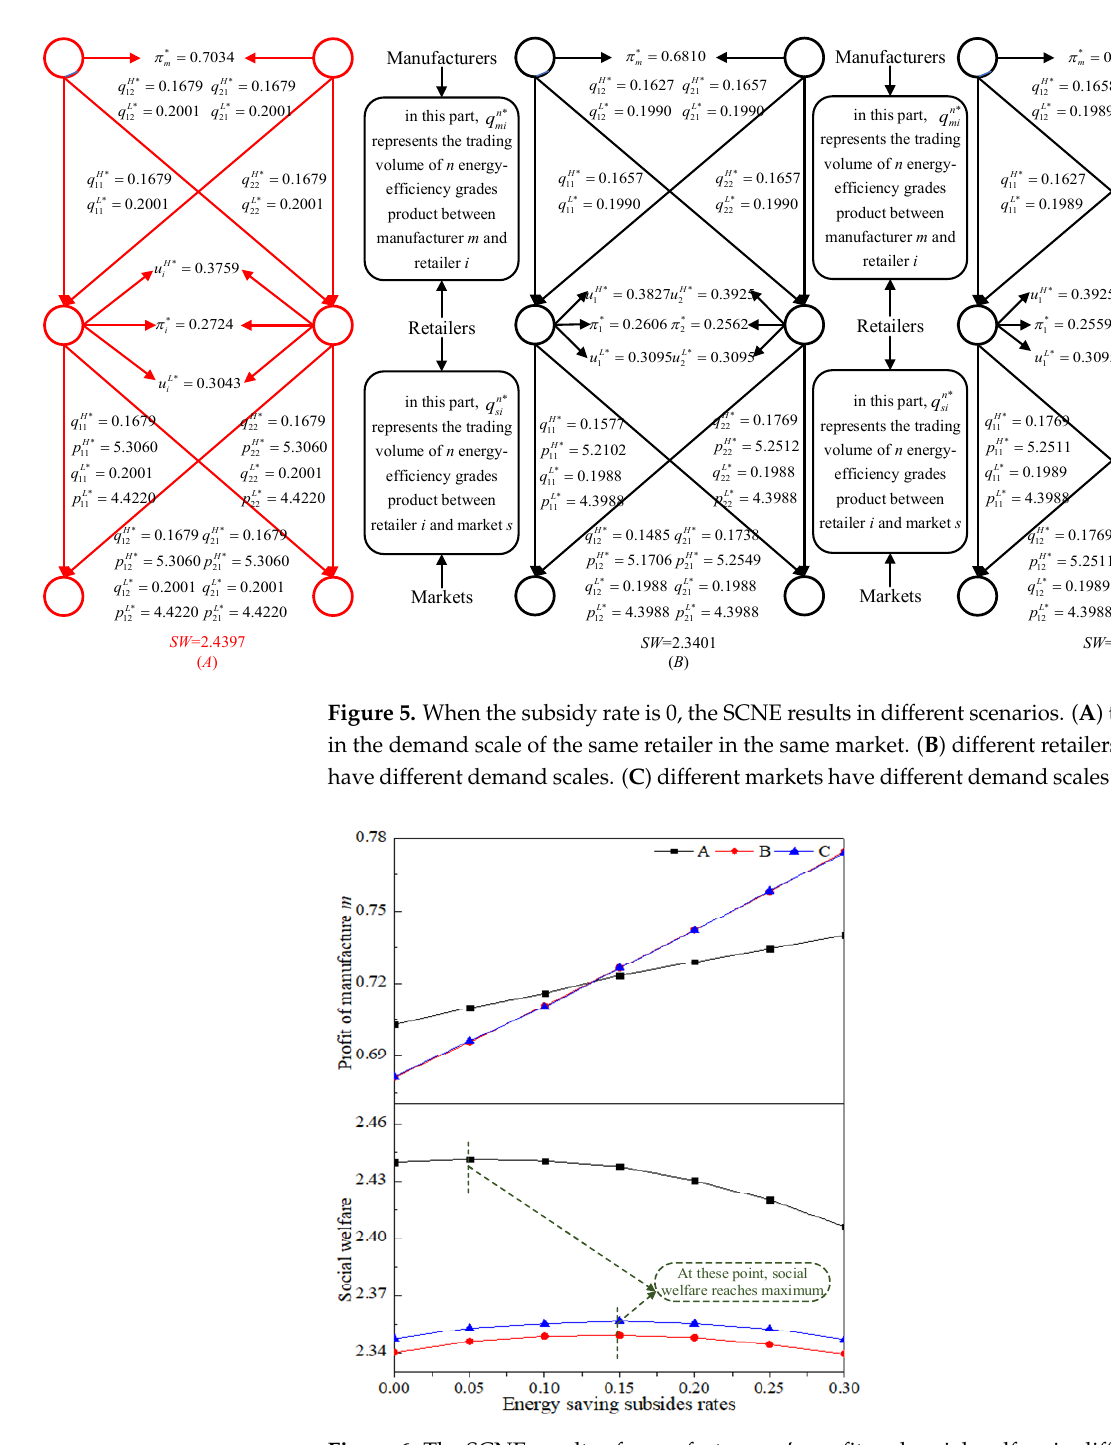
Figure 7. The SCNE results of retailer i ’s profit and marketing efforts for HEEP in different scenarios. Through Figure 6, we find that with the increase of